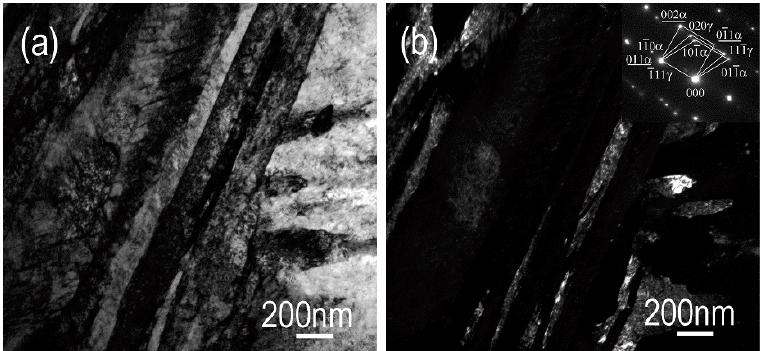
Figure 3. ( a ) Bright field (BF) and ( b ) Dark field (DF) micrographs of the retained austenite at 25 °C, with the corresponding selected area electron diffraction (SAED) pattern shown in ( b ).